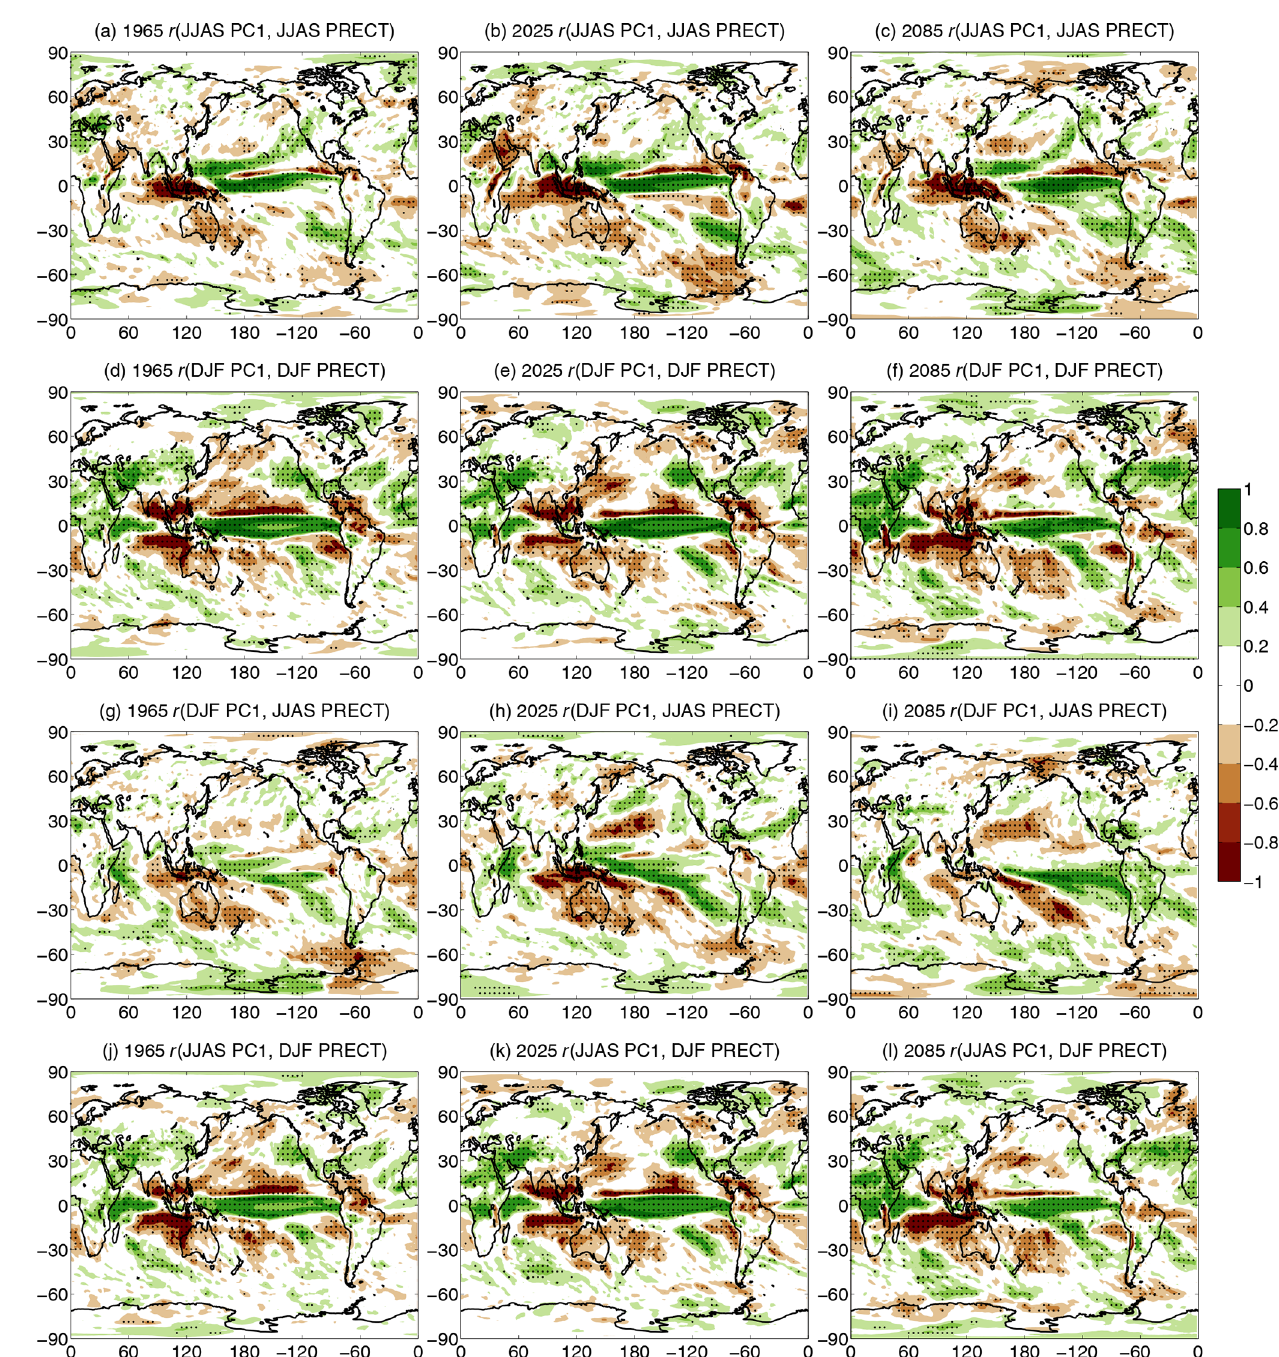
Figure 4. Ensemble-based correlation coefficient r maps for the (a–c) JJAS PC1 and JJAS PRECT, (d–f) DJF PC1 and DJF PRECT, (g– i) DJF PC1 and JJAS PRECT, and (j–l) JJAS PC1 and DJF PRECT. Specific years are indicated in the panels. Dots represent geographical locations where the correlation coefficient is significant at the 95% level. For better visibility, only every fourth grid point is